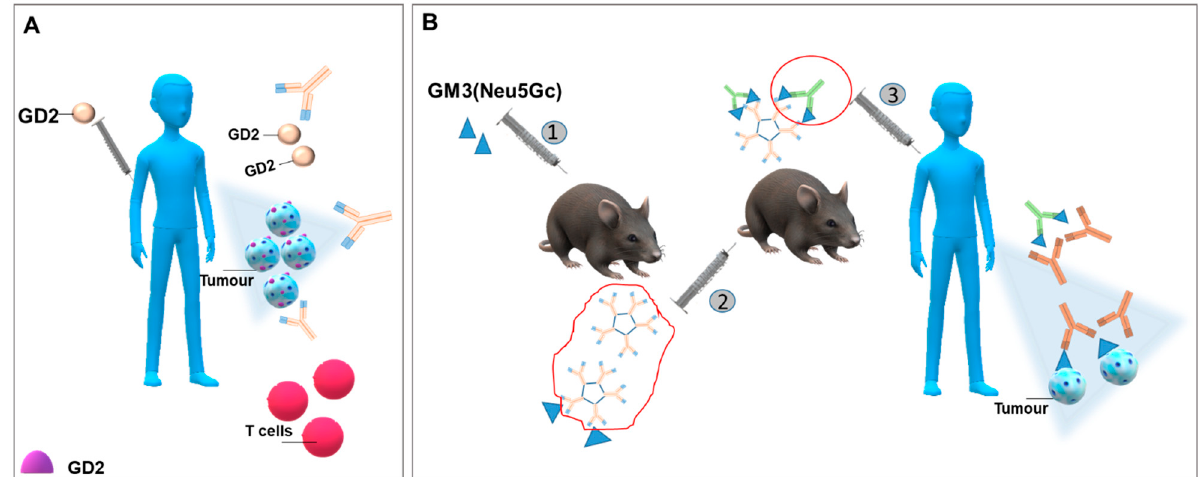
Figure 2. Gangliosides as antigens for formulating vaccines against tumours. ( A ) Scheme of a vaccine planned to stimulate a response against ganglioside GD2. GD2 is administered associated to KLH (keyhole limpet haemocyanin), BSA (bovine serum albumin), or TT (tetanus toxoid) and elicits an antibody response against tumour cells exposing the same ganglioside. This, in turn, activates a specific anti-tumour T cell response. ( B ) Schematic picture of Racotumomab (1E10) preparation and action. (1) GM3 (Neu5Gc), enclosed in liposomes, is injected into a Balb/c mouse and induces the release of IgM antibodies; (2) IgM antibodies targeting GM3 (Neu5Gc) are isolated and further injected into a second Balb/c mouse, triggering the release of IgG anti-idiotype antibodies. These last antibodies are known as Racotumomab and (3), when they are injected into a patient, are able to recognize cancer cells expressing GM3 (Neu5Gc) and to stimulate the immune response.